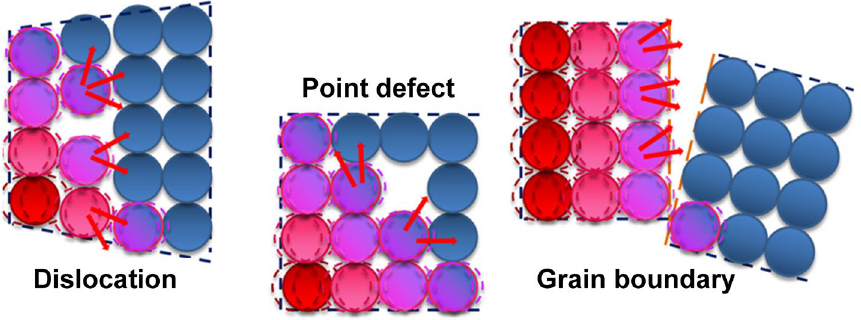
Fig. 2 Schematic illustrations of phonon scattering in crystalline materials caused by defects